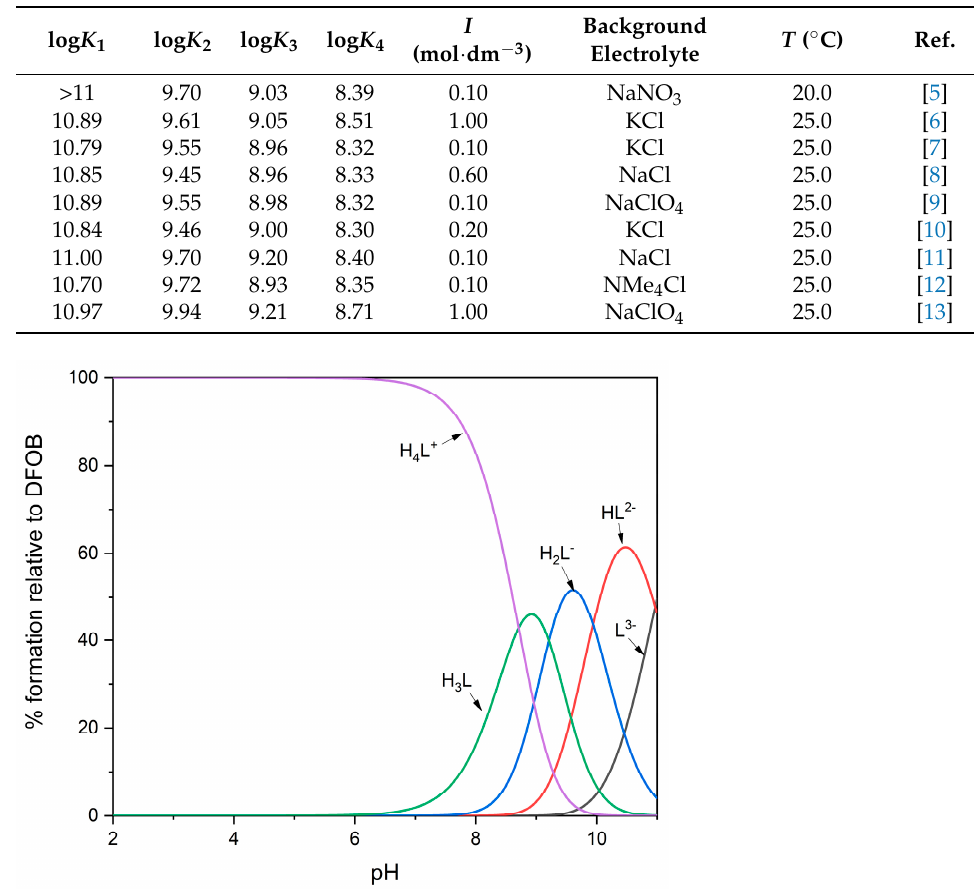
Table 1. Literature data of protonation constants of DFOB under different experimental conditions.